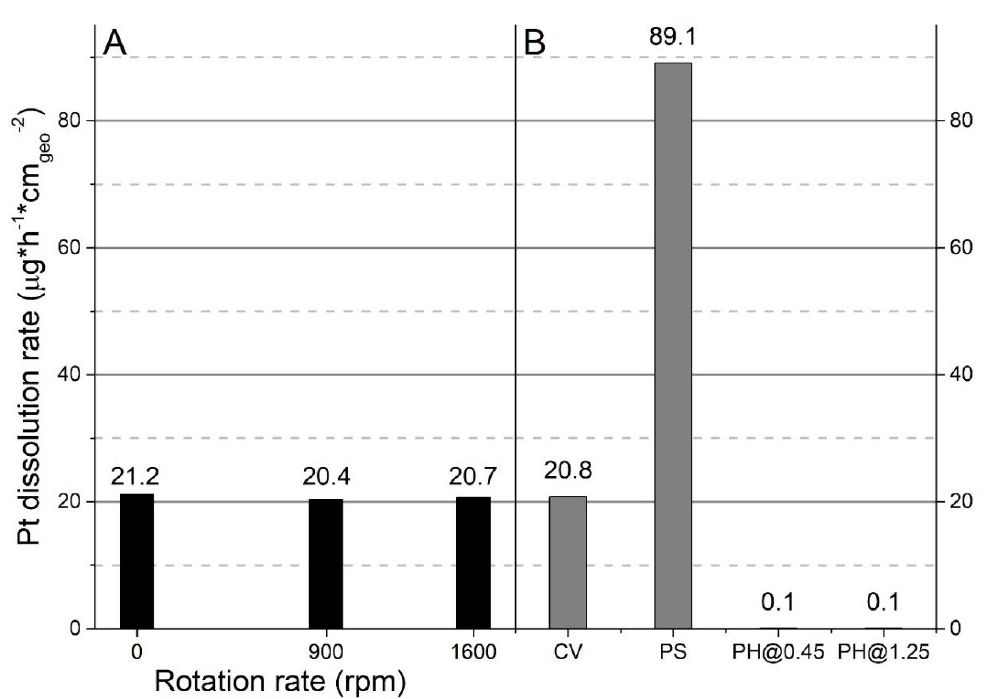
Figure 4. ( A ) Pt dissolved electrochemically in a rotating disc electrode (0.0314 cm − 2 ) setup in air; ( B ) the amount of Pt dissolution by cyclic voltammetry (CV), chronoamperometry-potential step (PS) with a 3 s step at 0.45 and 1.25 V vs. RHE (PS), potential hold (PH) at 0.45 V vs. RHE for 24 h, and PH at 1.25 V vs. RHE. Electrolyte: 1M HCl, RE: Ag/AgCl.